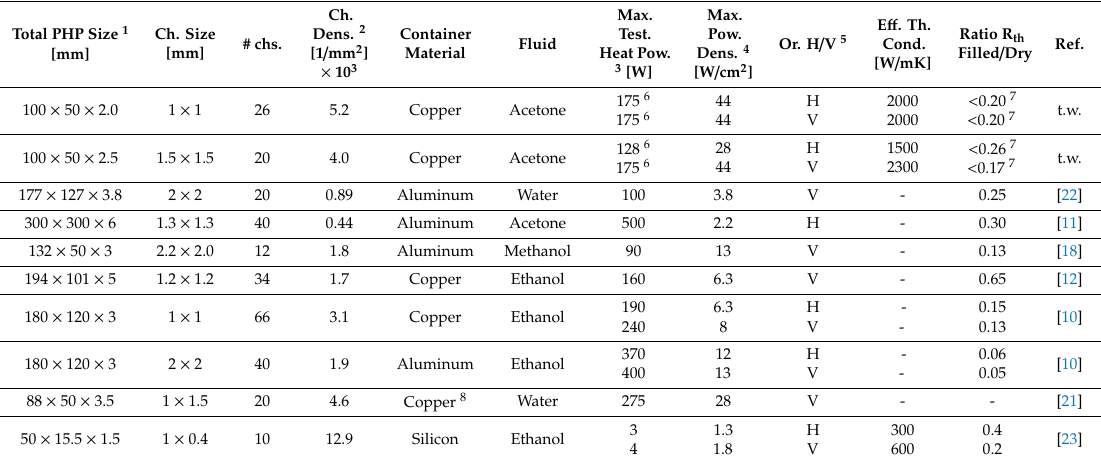
Abbreviations in table: channel size (Ch. size), number of channels (# chs.), channel density (Ch. dens.), maximum tested heat power (Max. test. heat pow.), maximum power density (Max. pow. dens.), orientation horizontal or vertical (Or. H / V), e ff ective thermal conductivity (E ff . th. cond.), reference (Ref.); this work (t.w); 1 total size (including marginal areas without channels); 2 number of channels divided by total PHP area; 3 maximum